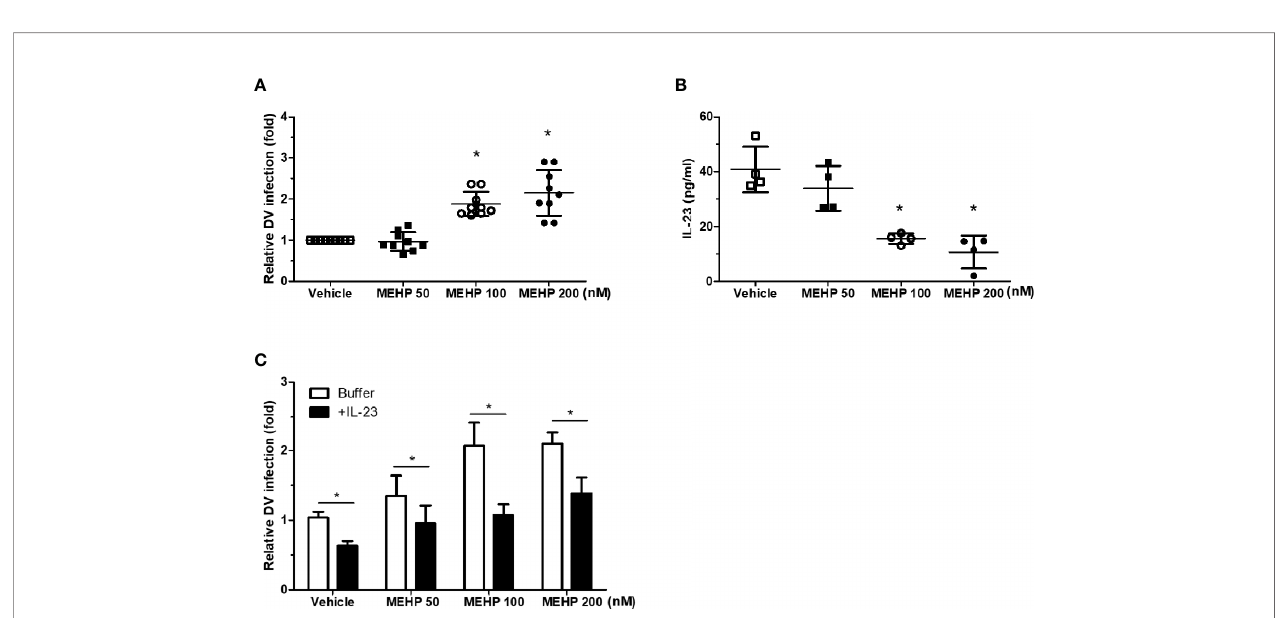
FIGURE 4 | IL-23 treatments decrease dengue virus (DV) infection in cultured human MDMs. (A) Human monocyte-derived macrophages (MDMs) were infected by DV and the relative viral counts were detected by real-time PCR. *P < 0.05 by Kruskal-Wallis test; N = 9, means ± SD. (B) Human MDMs were infected by DV, and the IL-23 levels in supernatants were detected by ELISA. *P < 0.05 by Kruskal-Wallis test; N = 4, means ± SD. (C) DV-infected human MDMs were treated with 100 pg/ml of IL-23 and the relative viral counts were detected by real-time PCR. *P < 0.05 by Kruskal-Wallis test; N = 4, means ±